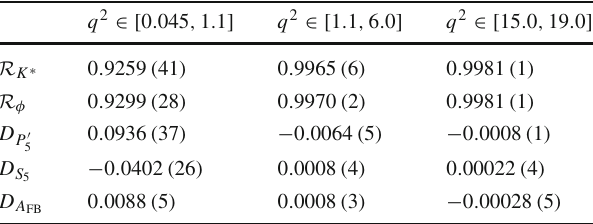
Table 3 SM predictions for LFU observables in different q 2 bins. The D observables have been defined in Eq.